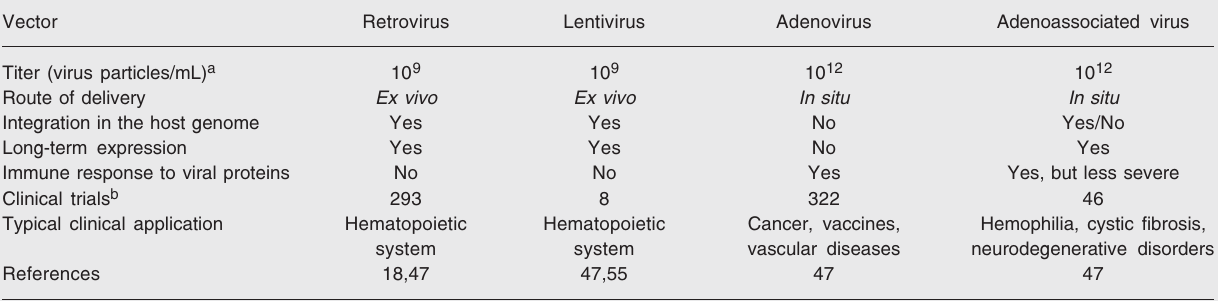
Table 1. Principal features of viral vectors. Vector Retrovirus Titer (virus particles/mL) a Route of delivery